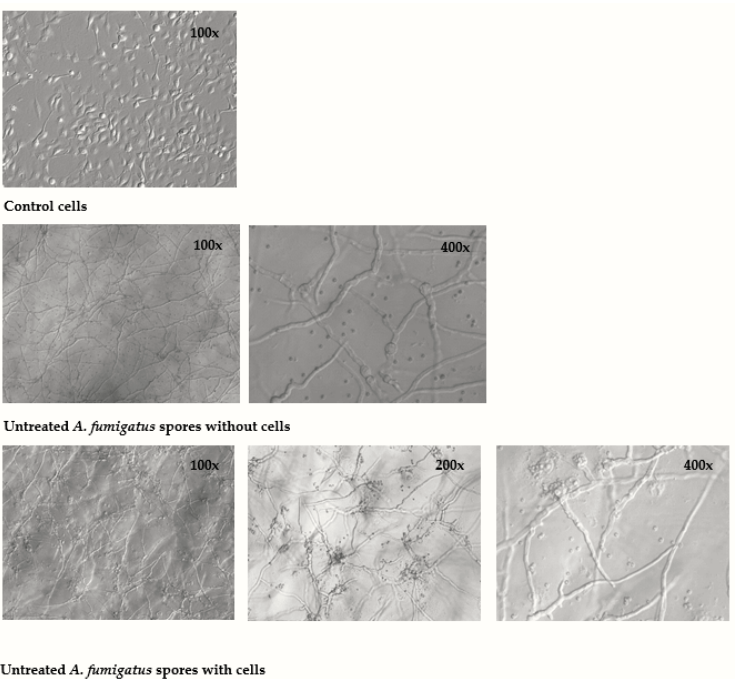
Figure 6. Germinative potential of untreated spores of A. fumigatus . Untreated A. fumigatus aerosolized spores (10 µg dry weight/mL) were added to cell culture dishes without or with BEAS-2B cells and incubated for 24 h. Medium blanks were included as control. The potential to form hyphae and spores were analyzed by light microscopic pictures with original magnification 100, 200 or 400×.